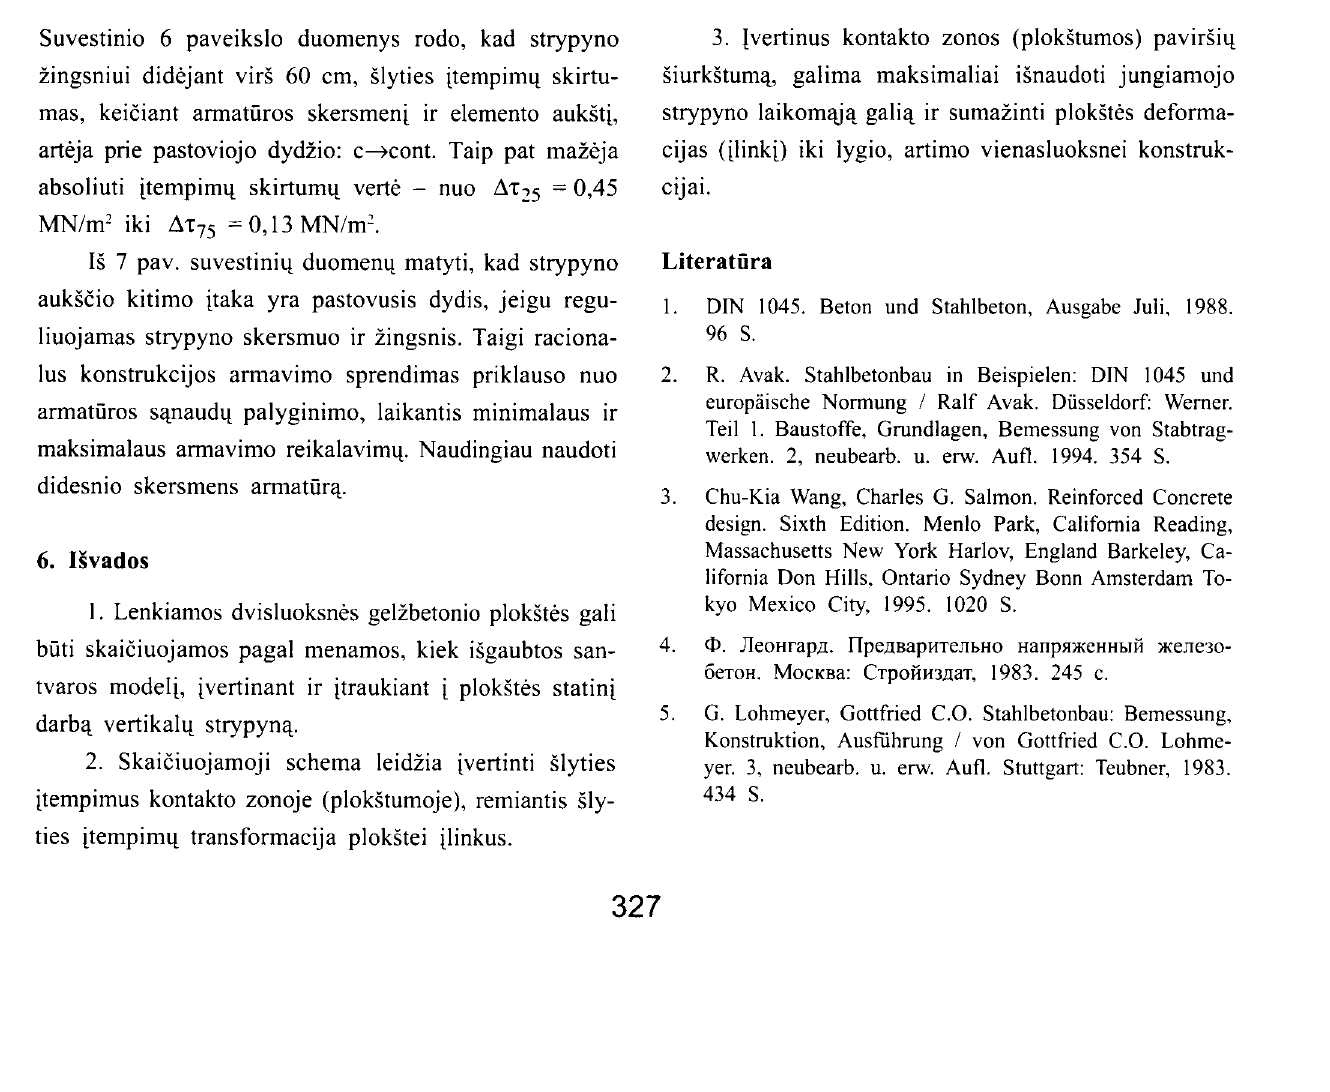
Fig 7. Dependency of shear stresses on the height of vertical shear reinforcement